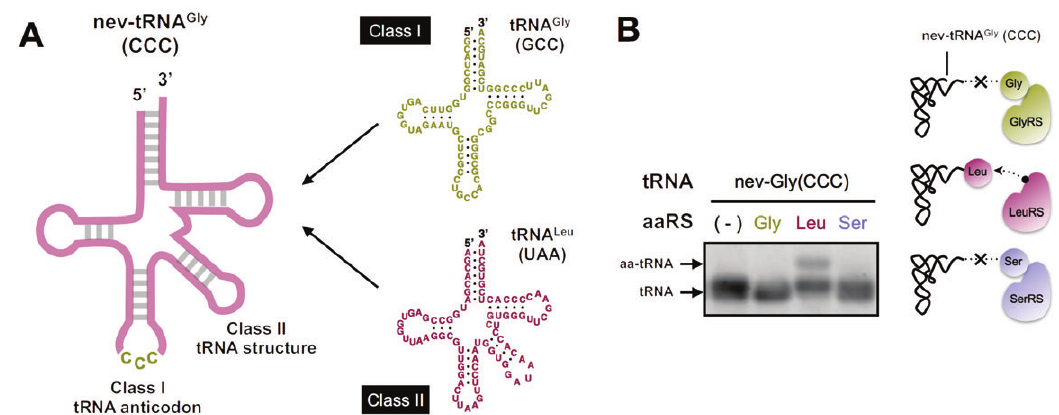
Figure 1 Nematode-specific tRNAs (nev-tRNAs) that decode an alternative genetic code. (A) nev-tRNAs have both class I and class II tRNA characteristics. (B) nev-tRNA can be solely charged with leucine. In vitro transcribed tRNAs were aminoacylated using recombinant C. elegans aminoacyl-tRNA synthetases (aaRSs). The aminoacylated tRNAs (aa-tRNAs) were sepa- rated on an acid-urea polyacrylamide gel (83)